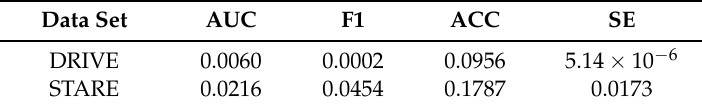
Table 3. t -test result of each index ( p < 0.05 significant).